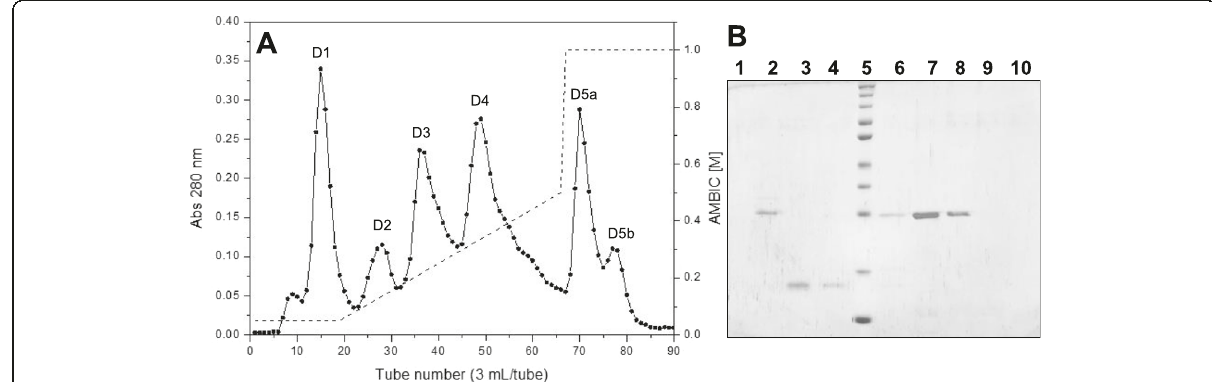
Fig. 2 a Chromatographic profile of fraction S3 on a DEAE Sepharose anion exchange column. Elution was initiated with 0.05 AMBIC, pH 7.8, followed by a gradient of AMBIC from 0.05 M to 0.5 M, pH 7.8, and finally 1 M AMBIC, pH 7.8. Fractions of 3 mL/tube were collected at a flow rate of 30 mL/hour. b 12 % SDS-PAGE. Lanes: 1 – tube 15 (D1), 2 – tube 28 (D2), 3 – tube 36 (D3), 4 – tube 40 (D3), 5 – molecular mass standard